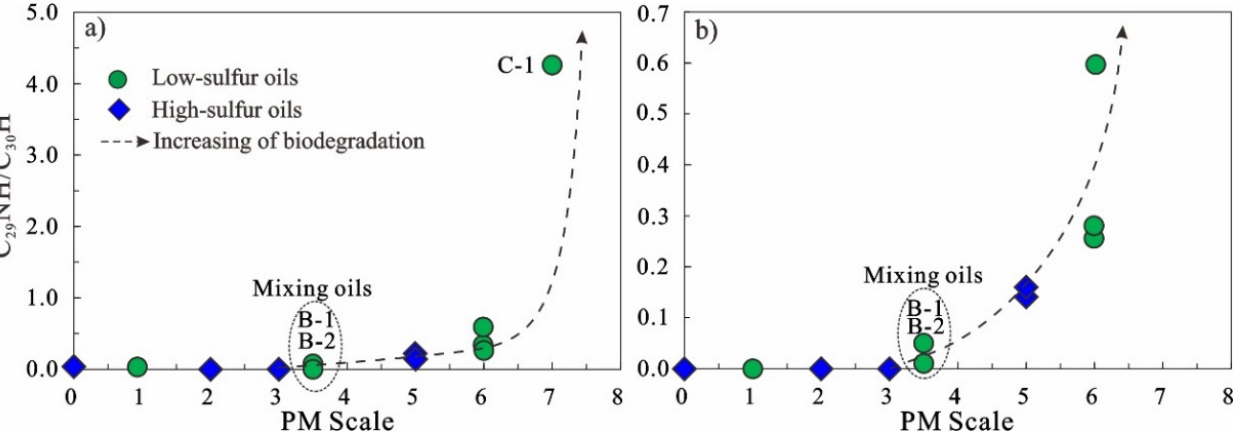
Figure 7. Cross plots of the degree of biodegradation (PM Scale) versus the C 29 NH/C 30 H biomarker ratio. ( b ) Partial enlargement of ( a ). Table 4. General characterization of saturated fractions of oil samples with different biodegradation levels (PM Scale).